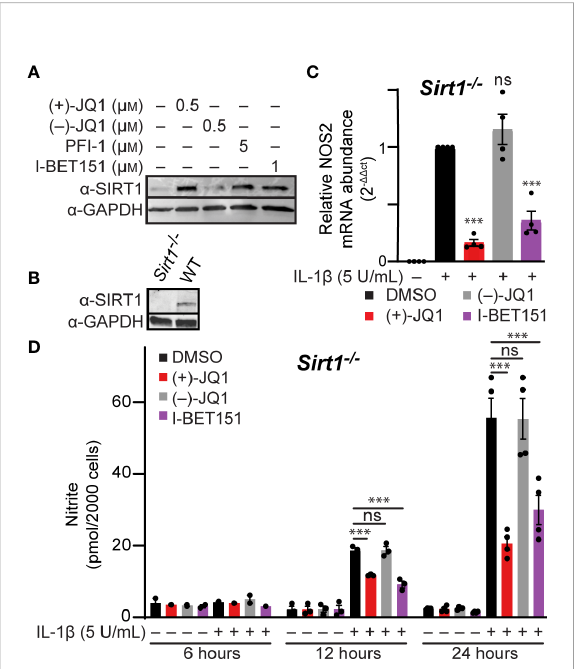
FIGURE 4 Pan-BET bromodomain inhibitors reduce IL-1 b -induced transcription of NOS2 and NO production independent of SIRT1. (A) Immunoblot using an antibody directed towards the SIRT1 protein in INS 832/13 cells treated with indicated pan-BET bromodomain inhibitor or DMSO for 24 hours. (B) Immunoblot analysis using antibody directed against SIRT1 protein or GAPDH loading control in WT and Sirt1 -/- INS 832/13 cell lines. (C) RT- qPCR analysis of NOS2 transcript levels in Sirt1 -/- INS 832/13 cell line treated with 0.5 m M (+)-JQ1, 0.5 m M ( – )-JQ1, 1 m M I-BET151, or DMSO and 5 U/mL IL-1 b for 12 hours. (D) Griess assay for nitrite accumulation in Sirt1 -/- INS 832/13 cells treated with 0.5 m M (+)-JQ1, 0.5 µM ( – )-JQ1, 1 m M I-BET151, or DMSO, and 5 U/ mL IL-1 b for 6, 12 or 24 hours. Immunoblots are